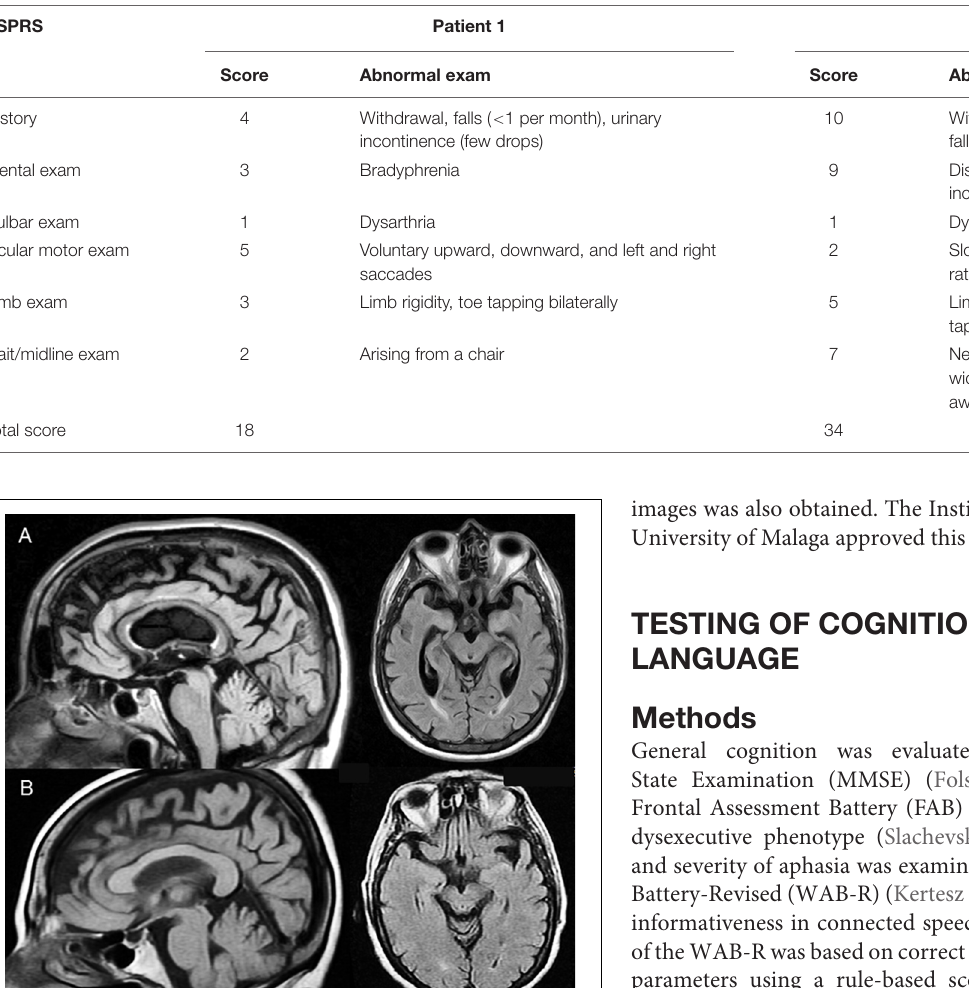
TABLE 1 | Progressive supranuclear palsy rating scale (PSPRS).